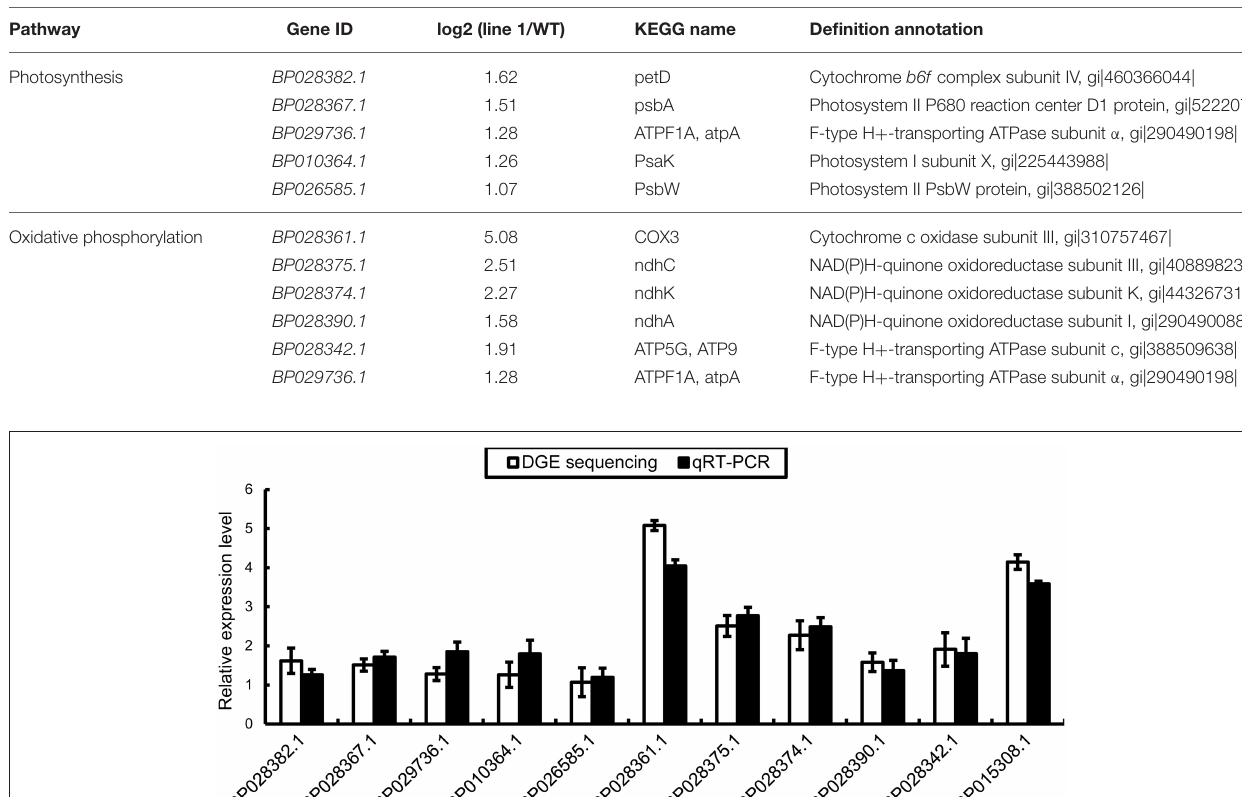
TABLE 2 | Differentially Expressed Genes related to photosynthesis and oxidative phosphorylation. Pathway Gene ID log2 (line 1/WT) KEGG name Definition annotation